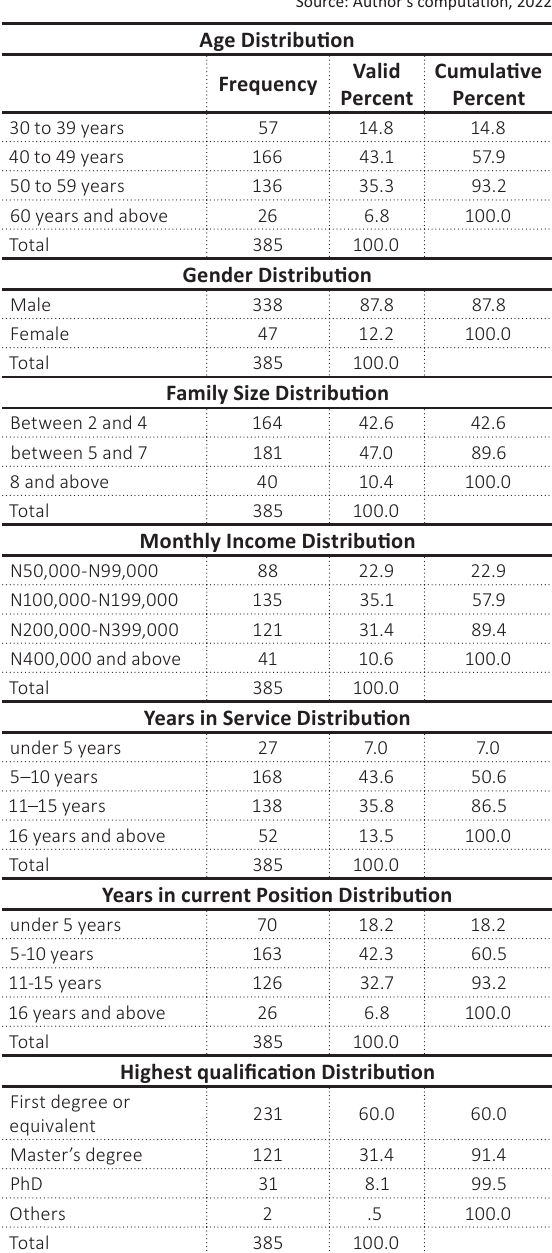
Table 2. Biodata distribution